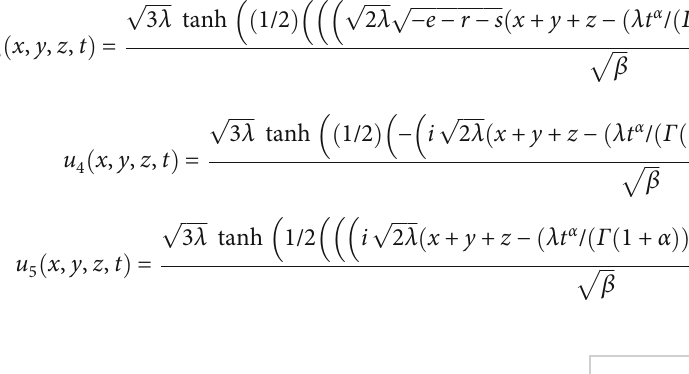
ffiffiffiffiffiffiffiffiffiffiffiffiffiffiffi